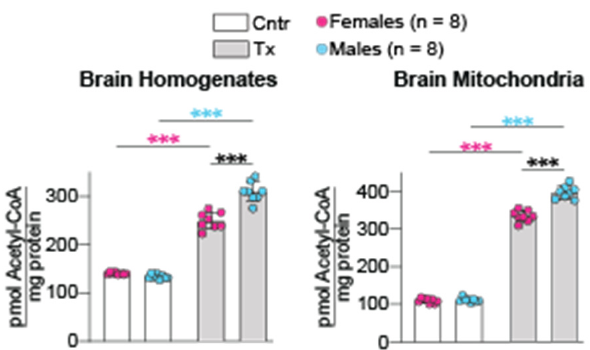
Figure 4. 8,14-DihydroxyEFV effect on the brain acetyl-CoA levels. Data represent the mean ± SD of the measurements in individual mice (8 female mice and 8 male mice). *** p ≤ 0.001 as assessed by two-way ANOVA with Tukey’s multiple comparison test. The asterisk color indicates significance between female mice (pink), male mice (blue) or male-female animals (black). Cntr, control mice; Tx, treated mice.